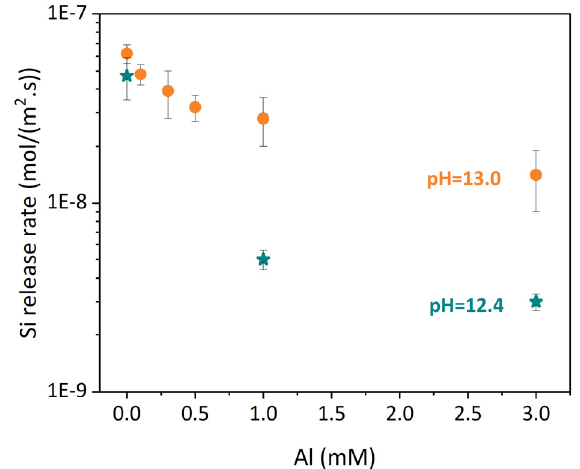
Figure 2. Si release rate (mol/(m 2 ∙ s)) from amorphous silica at 40 °C as a function of Al concentration at pH 12.4 and 13. Adapted from [43].